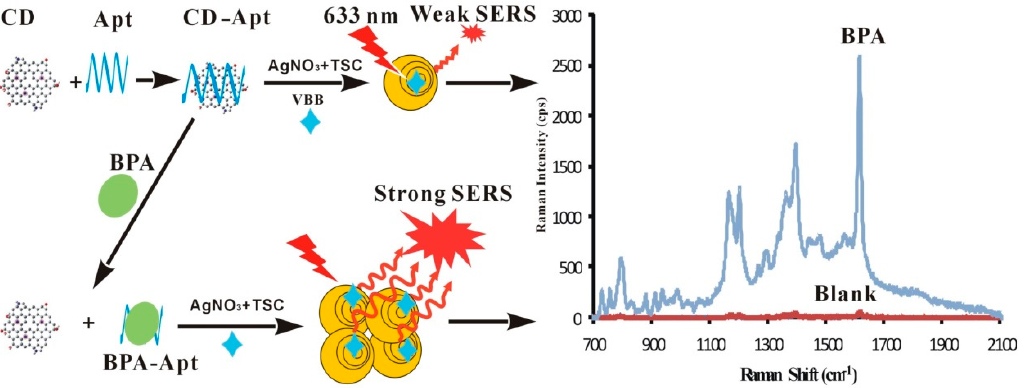
Figure 1. Mechanism of the carbon dots (CDs) catalytic reaction and the analysis principle.